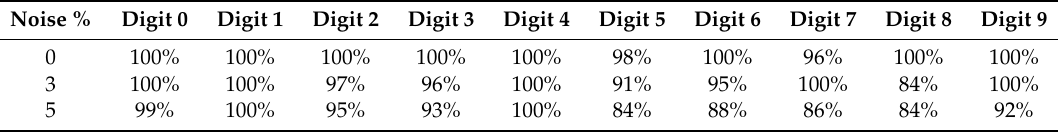
Table 5. Average accuracy of inference test of 10 × 10 digit image